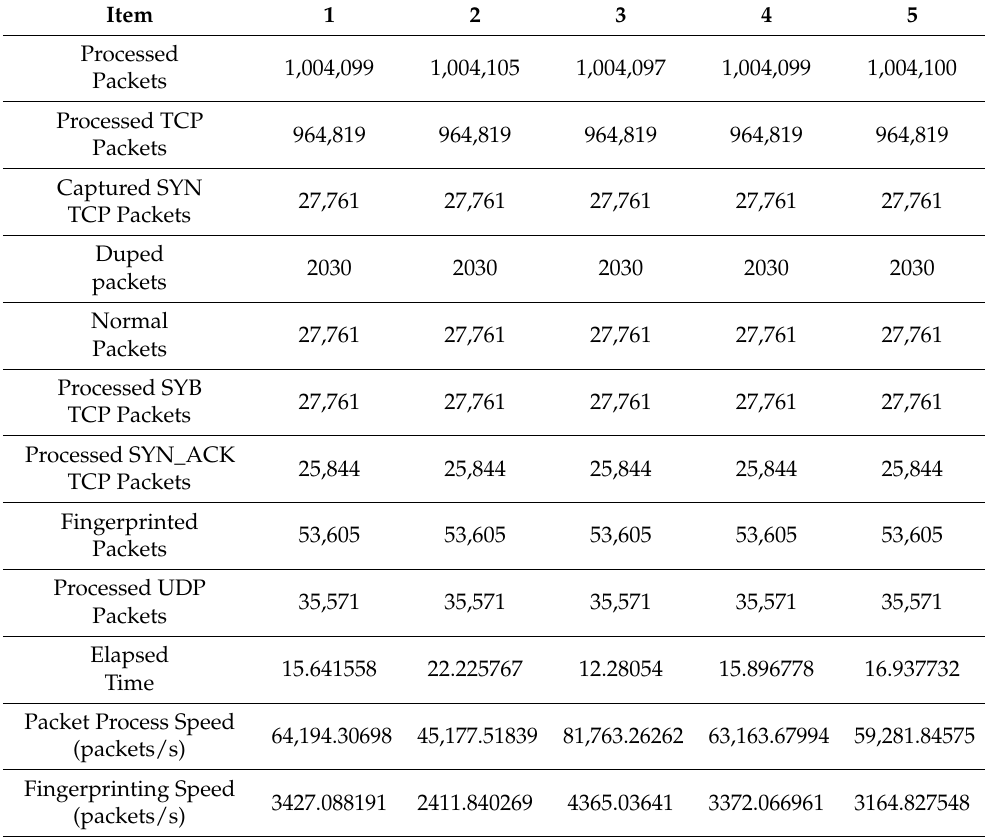
Table 10. Test results for the fingerprinting extraction success